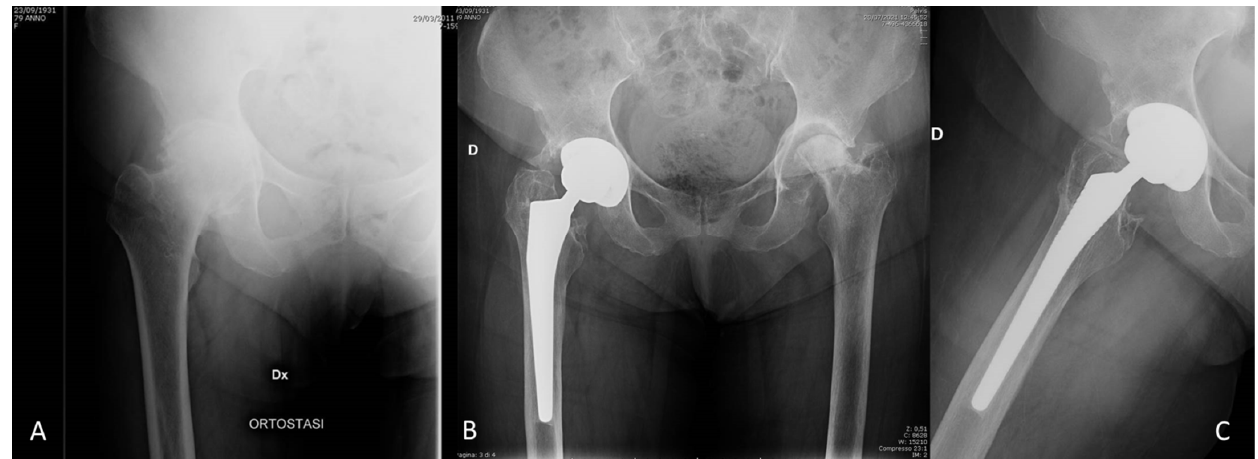
Figure 6. Ten-year radiographic follow-up of a THA performed in a woman aged 79 years with hip osteoarthritis, showing excellent osseointegration around the stem, lack of radiolucent lines, and minimal signs of stress-shielding with slight distal cortical hypertrophy and pedestal formation. ( A ) Preoperative AP radiograph of the affected hip. ( B , C ) AP and lateral radiographs at 10-year follow-up. A Brooker 3 heterotopic ossification was detectable laterally inside the capsule. D means right side.